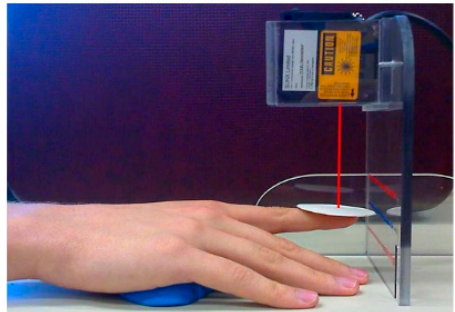
Figure 2. Recording of index finger tremor using the laser sensor. The beam of the laser is pointing down on the middle of the white cardboard while the participant’s palm rests on a piece of molded clay. EEG was measured simultaneously with tremor using a 64-channel MRI-compatible EEG cap and a SynAmps2 amplifier (Compumedics-Neuroscan Inc., Charlotte, NC, USA). This technology